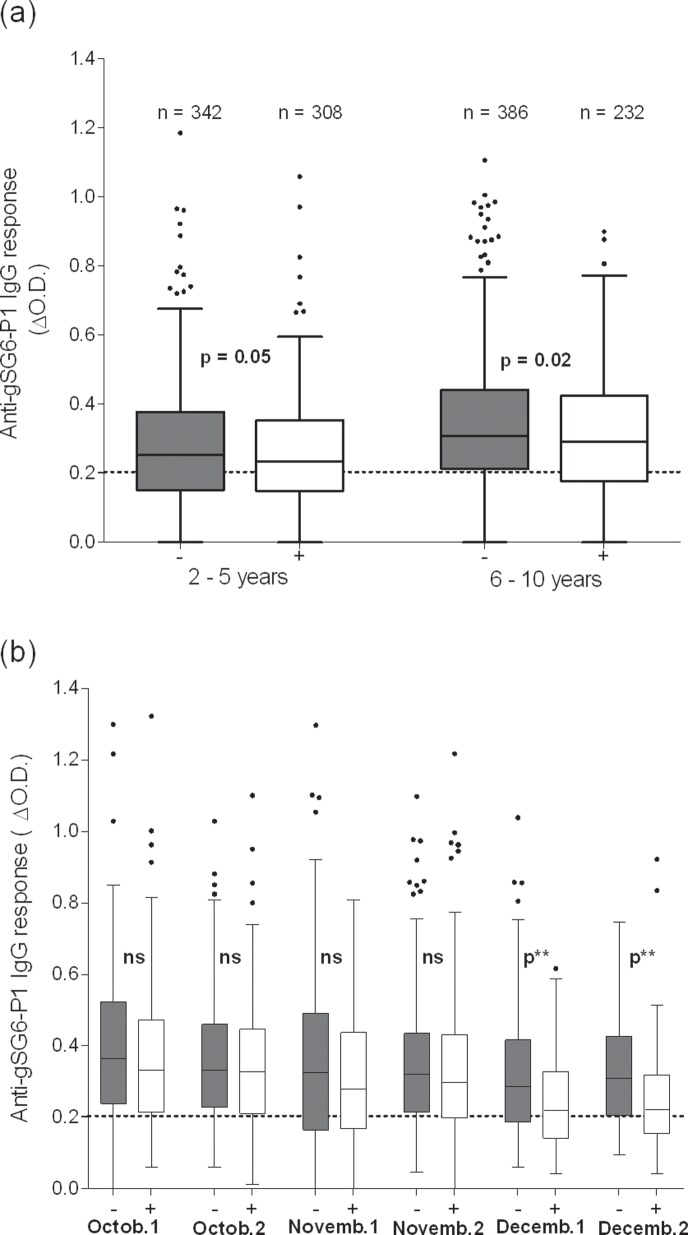
IgG responses to gSG6-P1 according to the use of ITN and age (in children) and sampling period (in adults).Specific IgG responses are shown for ITN (white boxes) and non-ITN (grey boxes) users according to age in children (Fig. 2a) and period of sampling in adults (Fig. 2b). Boxes indicate the middle 50% of the data; horizontal lines in the boxes indicate medians of the individual data; lengths of boxes correspond to the inter-quartile ranges. The horizontal black dotted line represents the cut-off of IgG responder and “n” the effectiveness of each individual group. Statistical significant differences of specific IgG between bed net and non-bed net users are indicated. October 1 and 2, November 1 and 2 and December 1 and 2 represent sampling periods between, respectively, 01st –15th and 16th –31st October, 01st –15th and 16th –30st November and 01st –15th and 16th –31st December 2008.